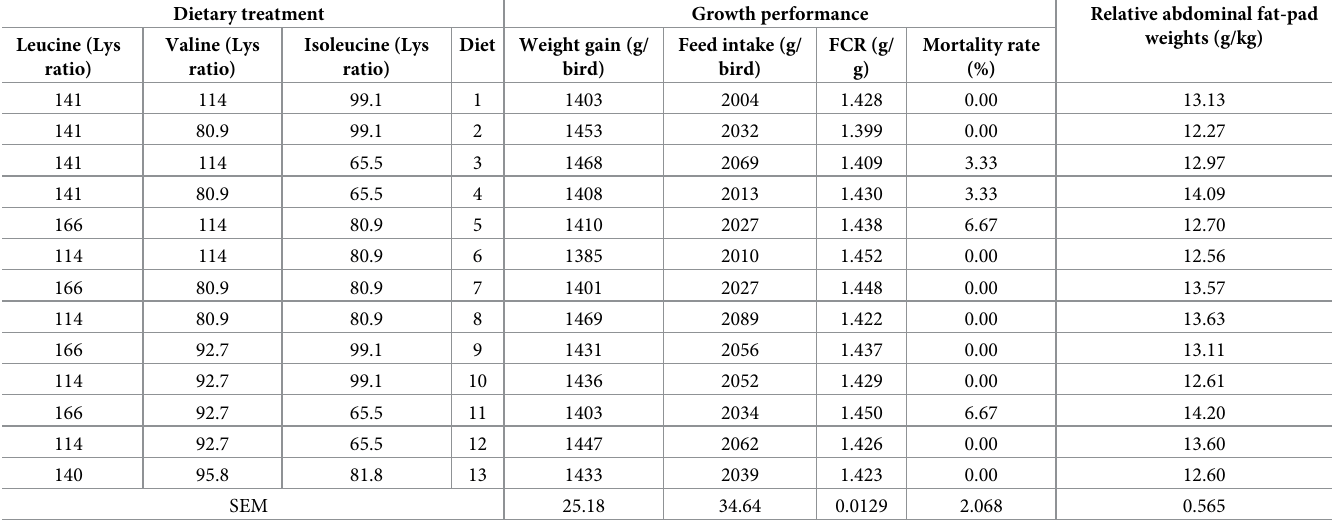
Table 6. Effects of dietary treatments on growth performance and relative abdominal fat-pad weights from 7 to 28 days post-hatch. Dietary treatment Growth performance Relative abdominal fat-pad